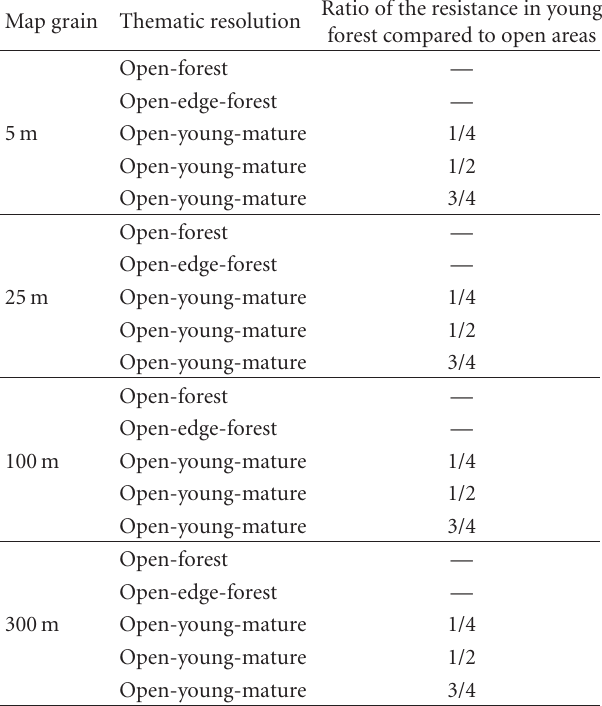
Table 2: Model composition. Each line in the Table led to 10 cost surfaces, since 10 values were assigned to resistance in open areas for each of these combinations. Without null models, 200 cost surfaces were thus created.